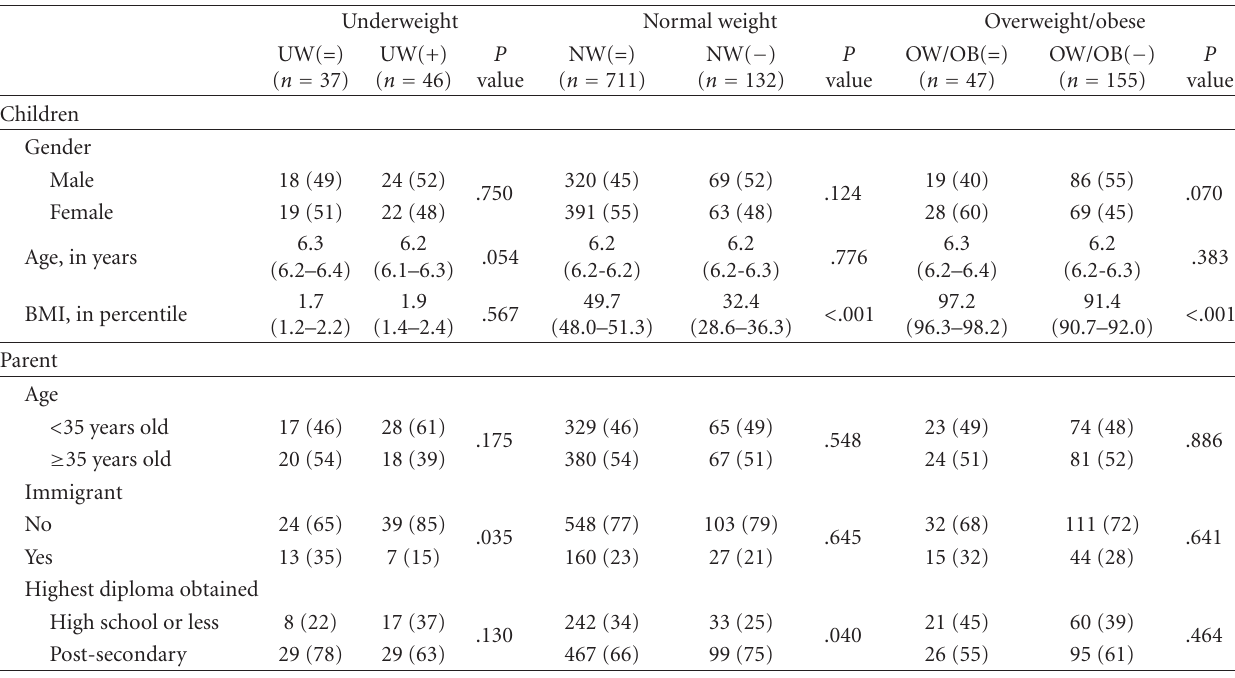
Table 1: Characteristics of the